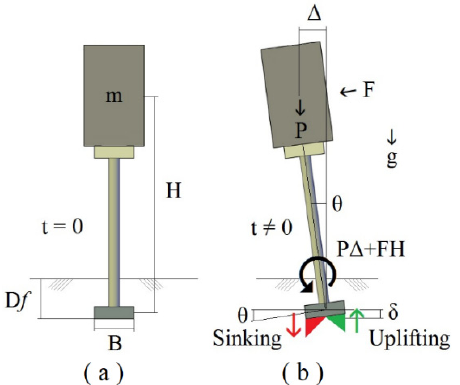
Figure 9. ( a ) Equivalent SDOFO model at t = 0, ( b ) displacements, angles of rotation of the SDOFO, and forces acting on the SDOFO at t ≠ 0. Where m is the equivalent SDOFO mass, H is the effective height of the equivalent SDOF model, B is the width of the square footing, θ is the angle of foundation rotation, P is the total weight of the actuator, F is the lateral force, ∆ is the horizontal displacement of the centroid of the dynamic target related to the centroid of the static target, and δ is the vertical displacement in one of the edges of the footing.